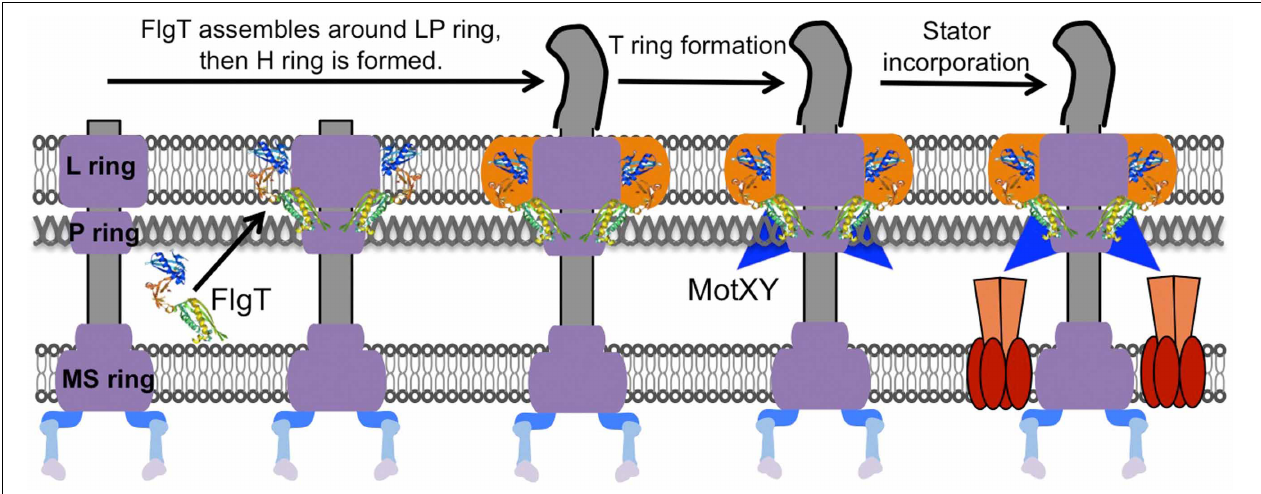
FIGURE 2 | Model for the basal body ring formation of the Na + -driven polar flagellum. The H ring is constructed dependent on FlgT proteins that assemble around the previously formed L ring and P ring. Next, MotX and MotY assemble around the basal body